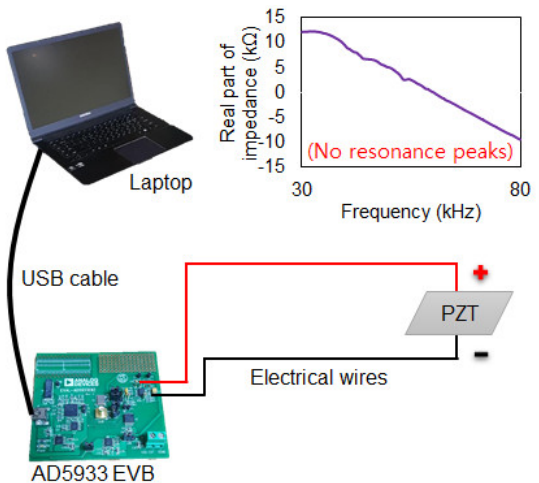
Figure 1. EMI measurement performed using an AD5933 evaluation board.